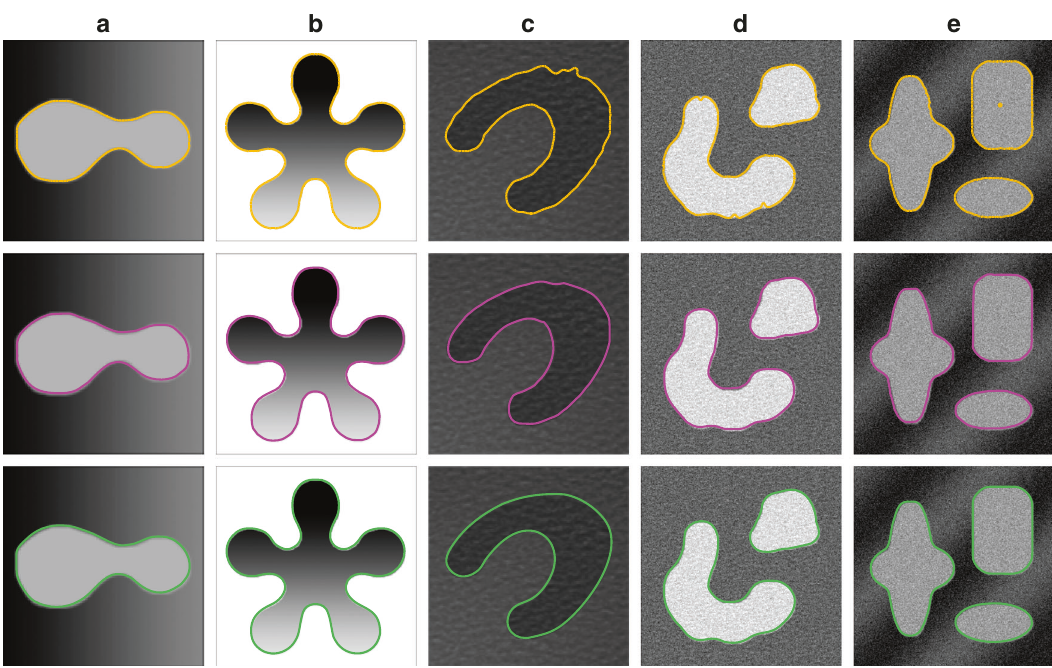
Fig. 4 Synthetic image segmentation results. a – e An image with inhomogeneous grayscale distribution in the background, an image with inhomogeneous grayscale distribution in the object, an image with a textured background, a textured image with noise, and an image with both intensity inhomogeneities and Gaussian noise. Yellow curves denote the boundaries obtained by the level-set algorithm, magenta curves represent the fi nal contours obtained by the crack- propagation method, and green curves denote the manual segmentation